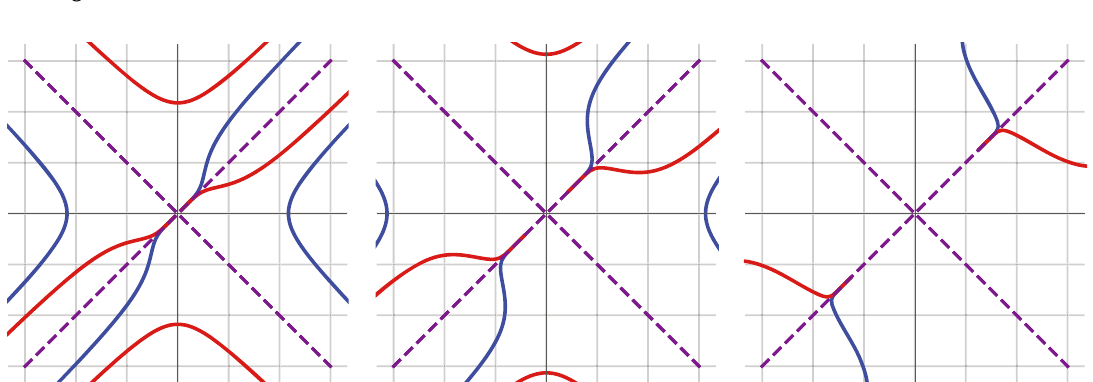
Figure 10: Spacelike ( blue ) and timelike ( red ) curves in (cid:2) 2 such that (cid:2) ( ) = ρ ρ τρ − cosh 2 , > τ 0